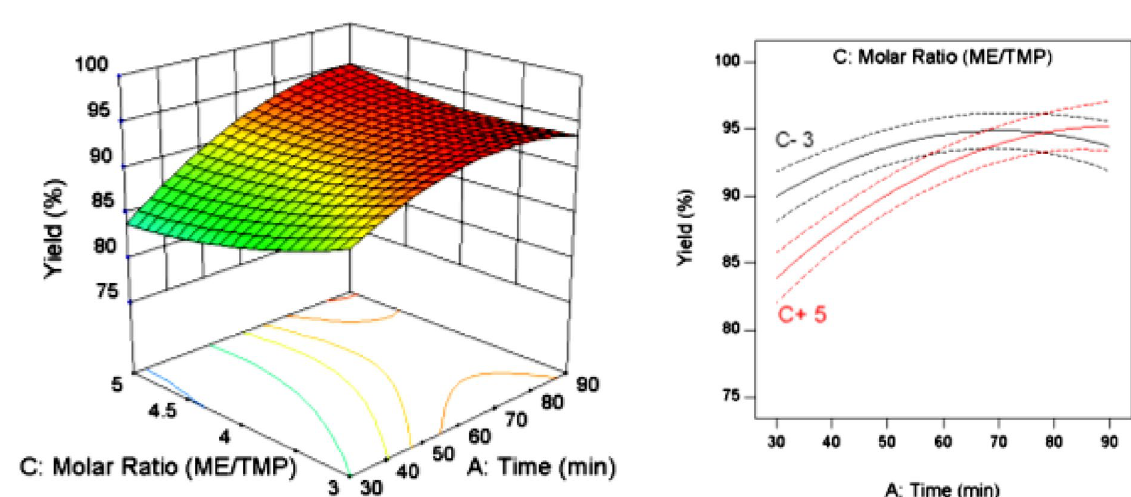
Figure 9. Interaction effect of reaction time and molar